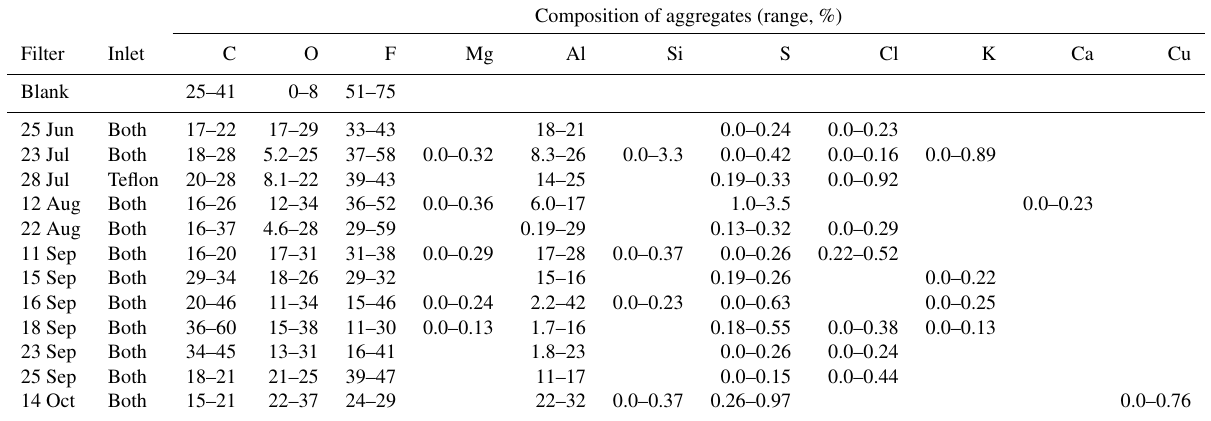
Table 3. Days at PEAV in 2014 with visible aggregates on filters, the inlet with aggregates (CEM – cation exchange membranes, Teflon filters, or both inlets), and the elemental composition of sections of Teflon with visible aggregates. Composition of aggregates (range,